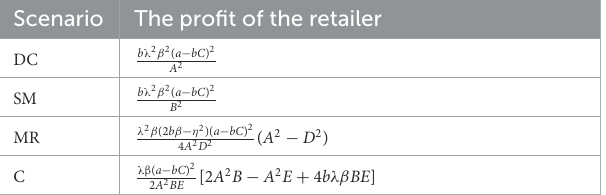
TABLE 5 Profits for the retailer under different decision-making